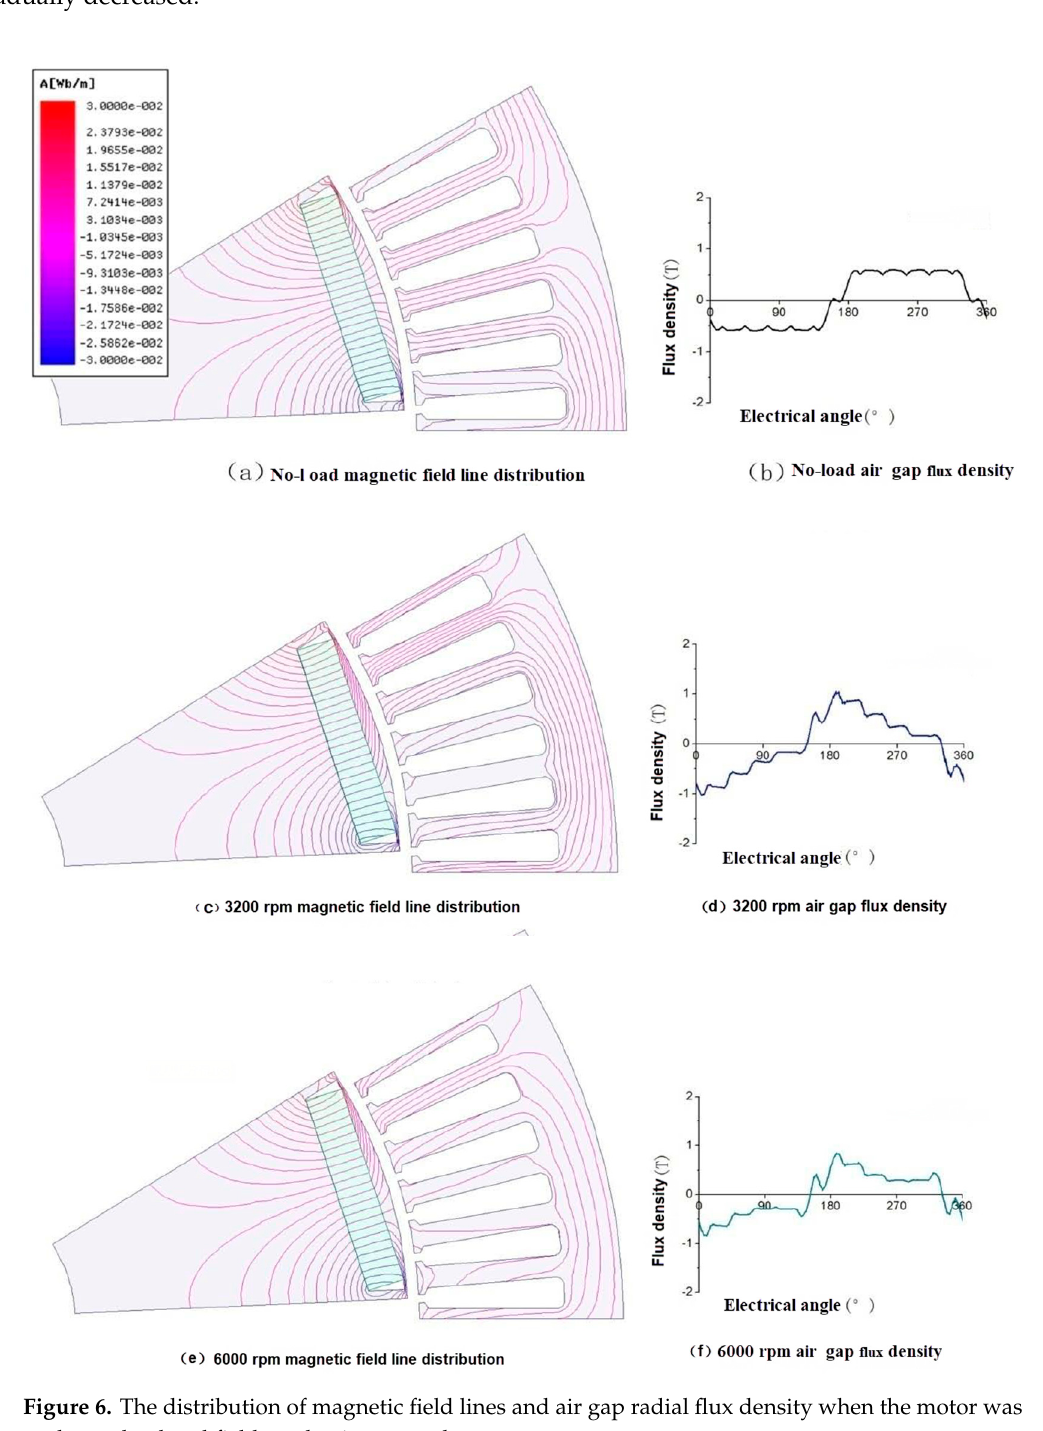
Figure 6. The distribution of magnetic field lines and air gap radial flux density when the motor was under no-load and field weakening control.